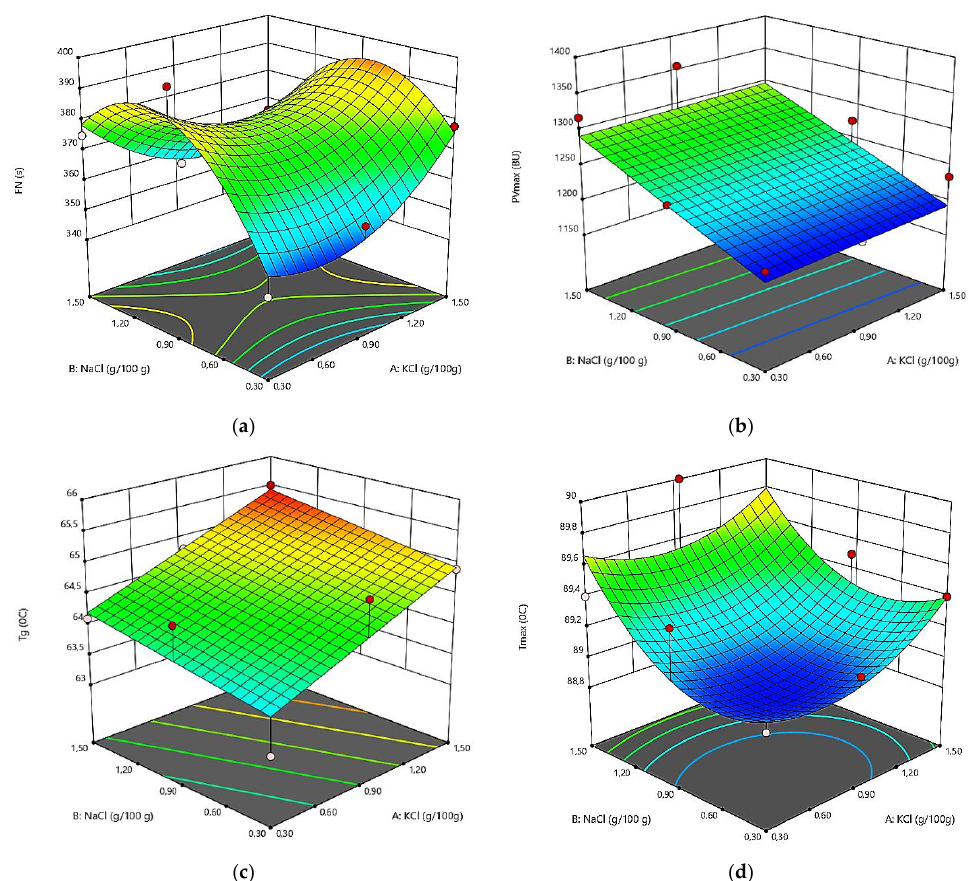
Figure 2. The graphical representations of the Falling Number and Amylograph parameters: ( a ) Falling Number value (FN); ( b ) peak viscosity (PV max ); ( c ) gelatinization temperature (T g ); ( d ) temperature at peak viscosity (T max ).